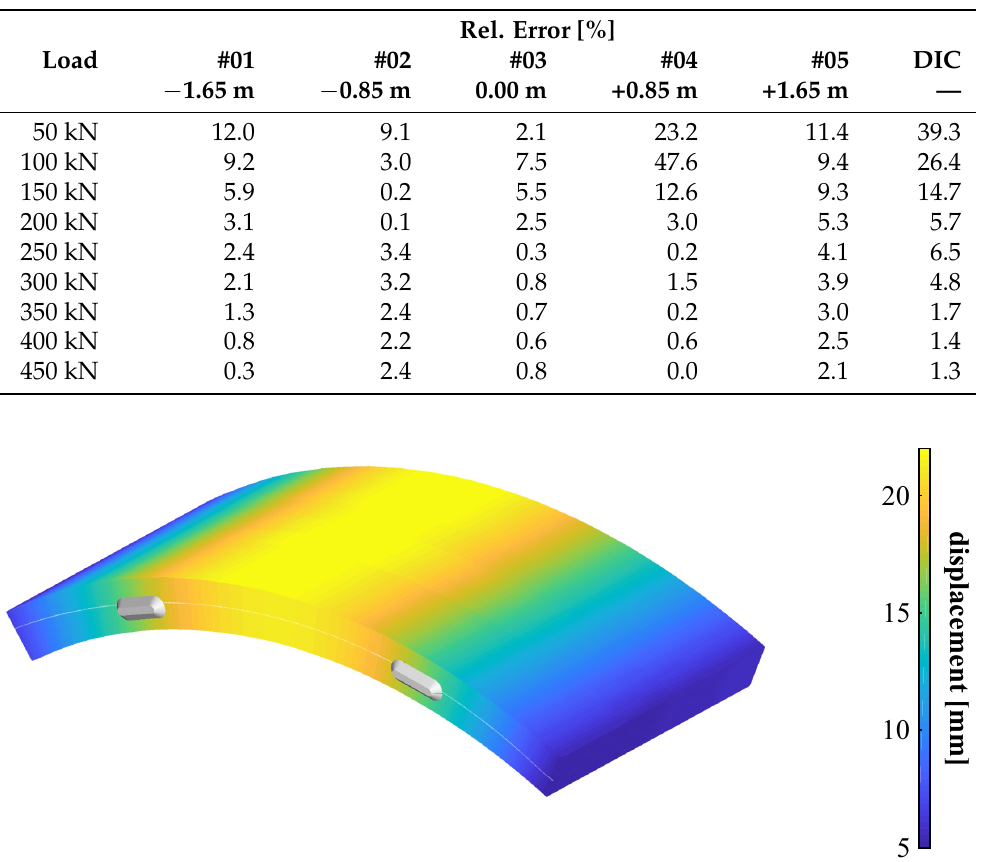
Table 5. Percentage errors for each load step during vertical loading at locations of LVDT sensors and mean percentage error with respect to distributed DIC measurements.